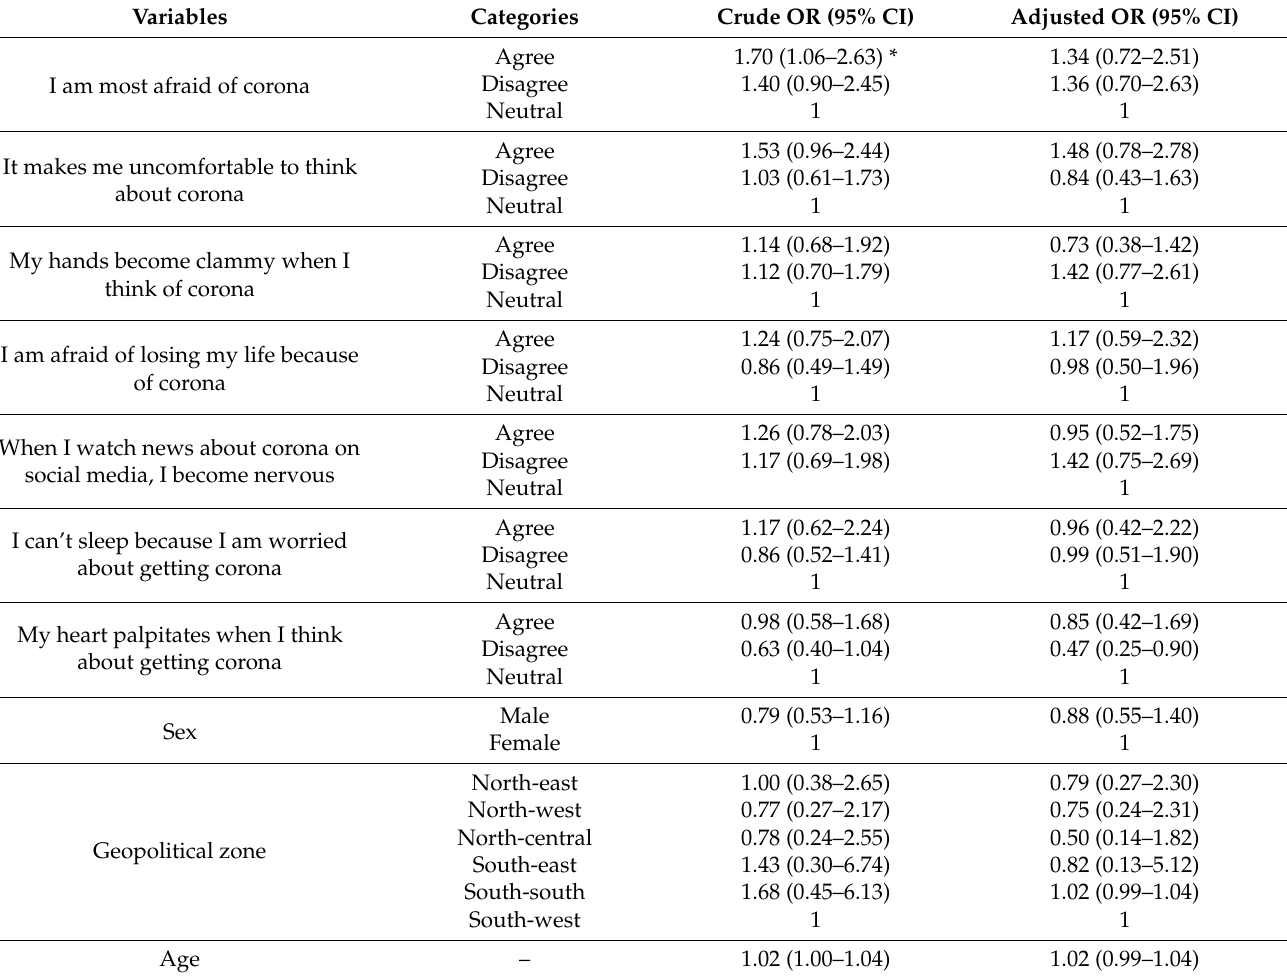
Table 2. Association between fear of coronavirus disease and COVID-19 vaccine uptake (n =